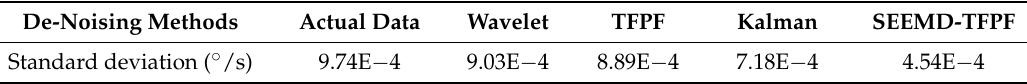
Table 2. SD comparison of different de-noising methods for temperature drift signal.